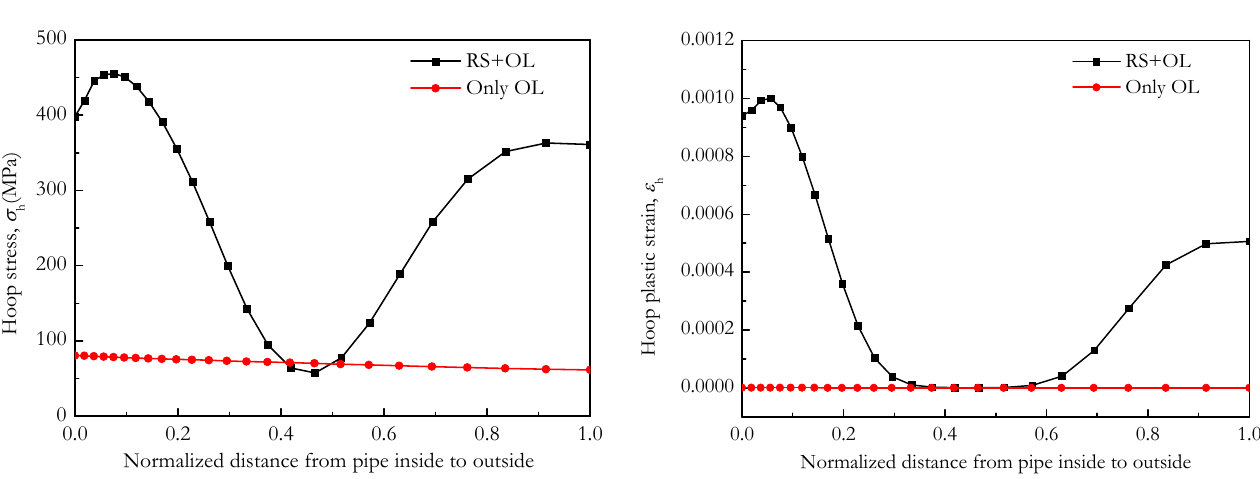
Figure 6: Hoop stress along pipe through-thickness. Figure 7: Hoop strain along pipe